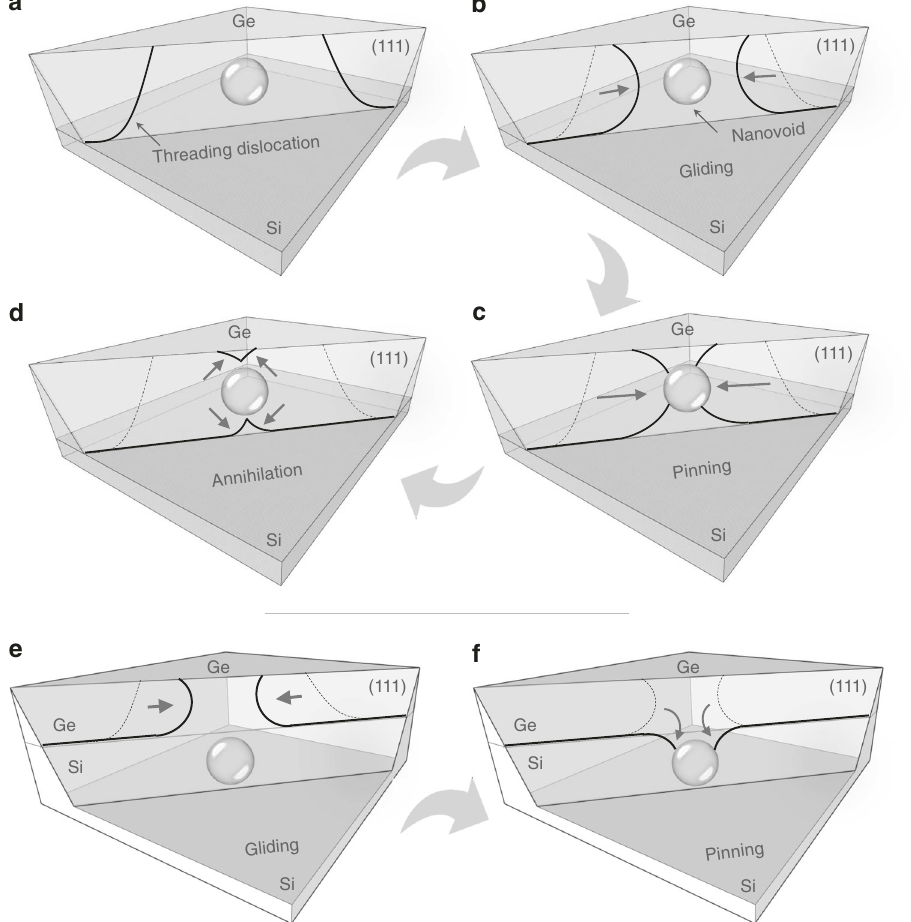
Fig. 4 Processes involving dislocations-void rearrangements. By introducing nanovoids inside the Ge layer, the dislocations with opposite Burgers vectors move easily along the {111} glide planes during high-temperature annealing ( a , b ) and react with each other ( c ), allowing the threading components to disappear ( d ). When the voids are located at the Ge/Si interface (on the Si side), dislocations bend towards the porous area, instead of emerging at the Ge surface causing their elimination through a similar process at the nearest free surface ( e , f